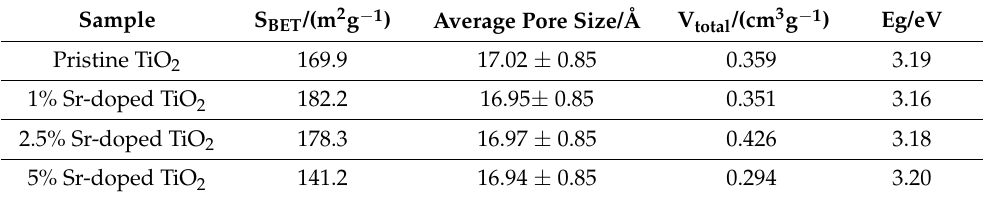
Figure 8. ( a ) Nitrogen adsorption-desorption isotherms, ( b ) BJH pore-size distribution and ( c ) DA average pore-size distribution plots of pristine, 1, 2.5 and 5% Sr-doped TiO 2 NPs. Table 1. BET surface area (S BET ), average pore size, pore volume (V total ) and energy band gaps (Eg) of as-synthesized nanocatalysts.